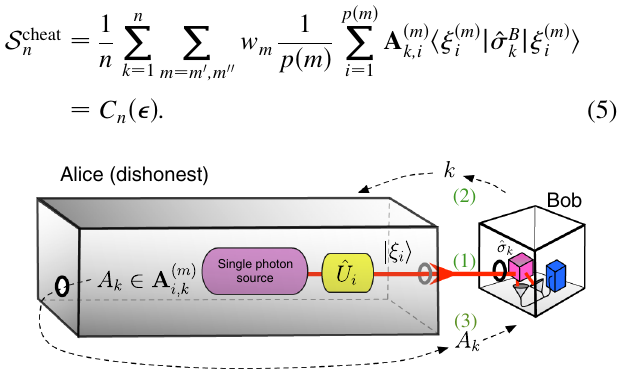
FIG. 6. Conceptual representation of the EPR-steering task for a dishonest Alice (to be compared to Fig. 1). In each round of the protocol, Bob (1) receives a photonic qubit, (2) announces a measurement setting, k , and (3) receives a ‘‘measurement’’ result from Alice. Bob must assume that Alice controls the source, her line, and her detectors (all enclosed in the gray box). In the case of a dishonest Alice, Alice’s optimal ‘‘cheating’’ strategy in- volves sending a single qubit prepared in a pure state j (cid:4) i i (using a single photon with a polarization state prepared by the corre- ^ U sponding unitary i ), chosen from an optimal set. She announ- ces a ‘‘measurement result’’ A k , or a null result (announces nothing), from a look-up table A ð m Þ k;i based on her preparation and Bob’s announced measurement direction. Note that the bounds for demonstrating EPR-steering, with no detection loop- hole, are set precisely to ensure that Alice cannot actually cheat—a dishonest Alice will fail to surpass the upper bound of any EPR-steering